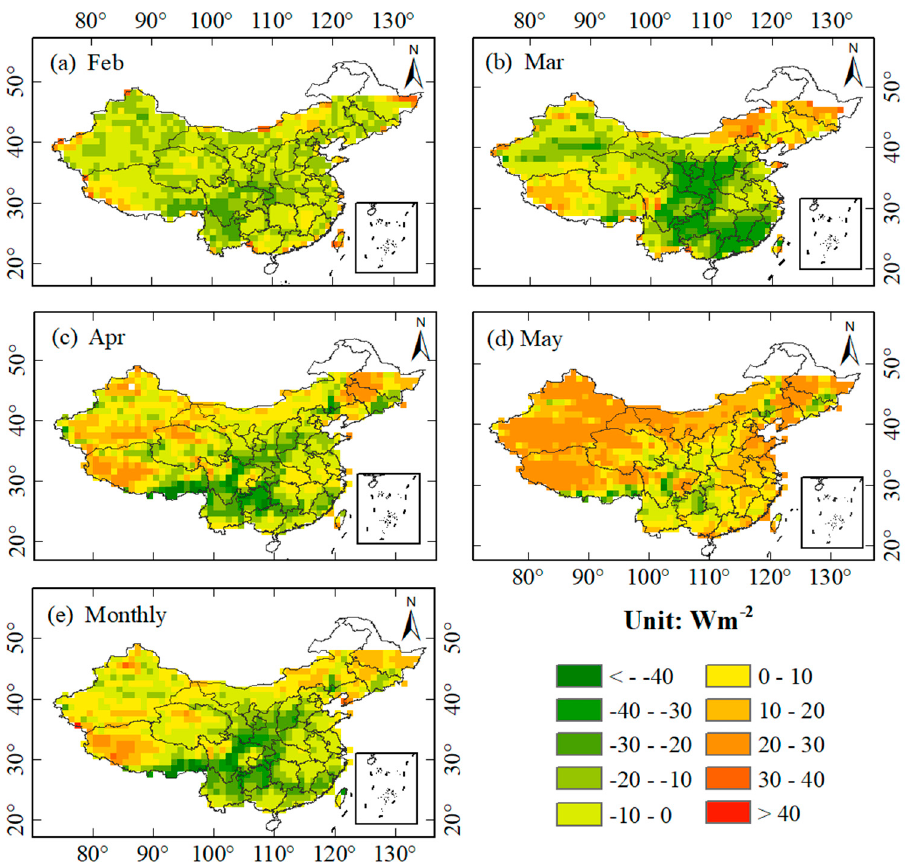
Figure 12. The differences of the monthly mean estimated R S data between the CERES–EBAF and the RF method (i.e., the CERES–EBAF estimates minus the RF-based estimates) from February to May 2016: panels ( a – d ) for each month; ( e ) for the difference of monthly mean R S from February to May.